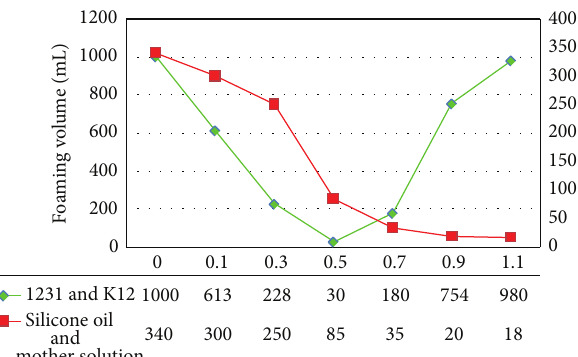
Figure 9: The synergistic effect of 1231 mixed with different anionic materials.